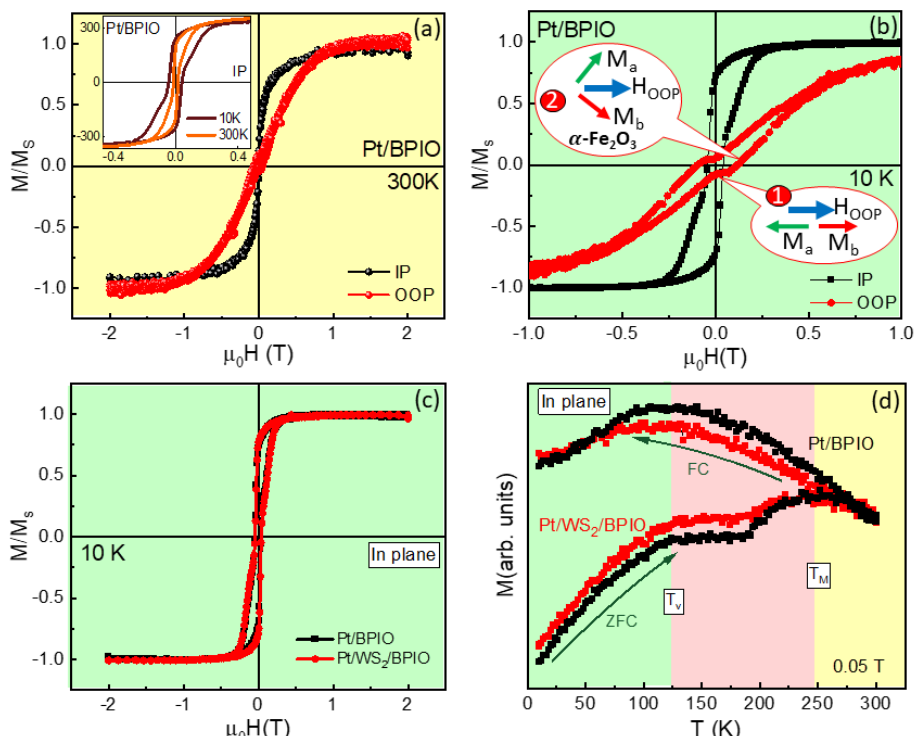
Figure 2. M − H curves are measured for ( a ) Pt/BPIO at 300 K in IP and OOP directions and ( b ) Pt/BPIO under low field at 10K in the IP direction. ( c ) IP M − H curves for Pt/BPIO and Pt/WS 2 /BPIO at 10 K. ( d ) M-T curves for both Pt/BPIO and Pt/WS 2 /BPIO for the IP direction. Inset of ( a ) has Pt/BPIO measured at 10 and 300 K for IP magnetic field. Inset of ( b ) indicates the − Fe 2 O 3 spin flop transition behaviors. M a (green) and M b (red) are two sublattices for − Fe 2 O 3. OOP magnetic field is noted as blue arrow.